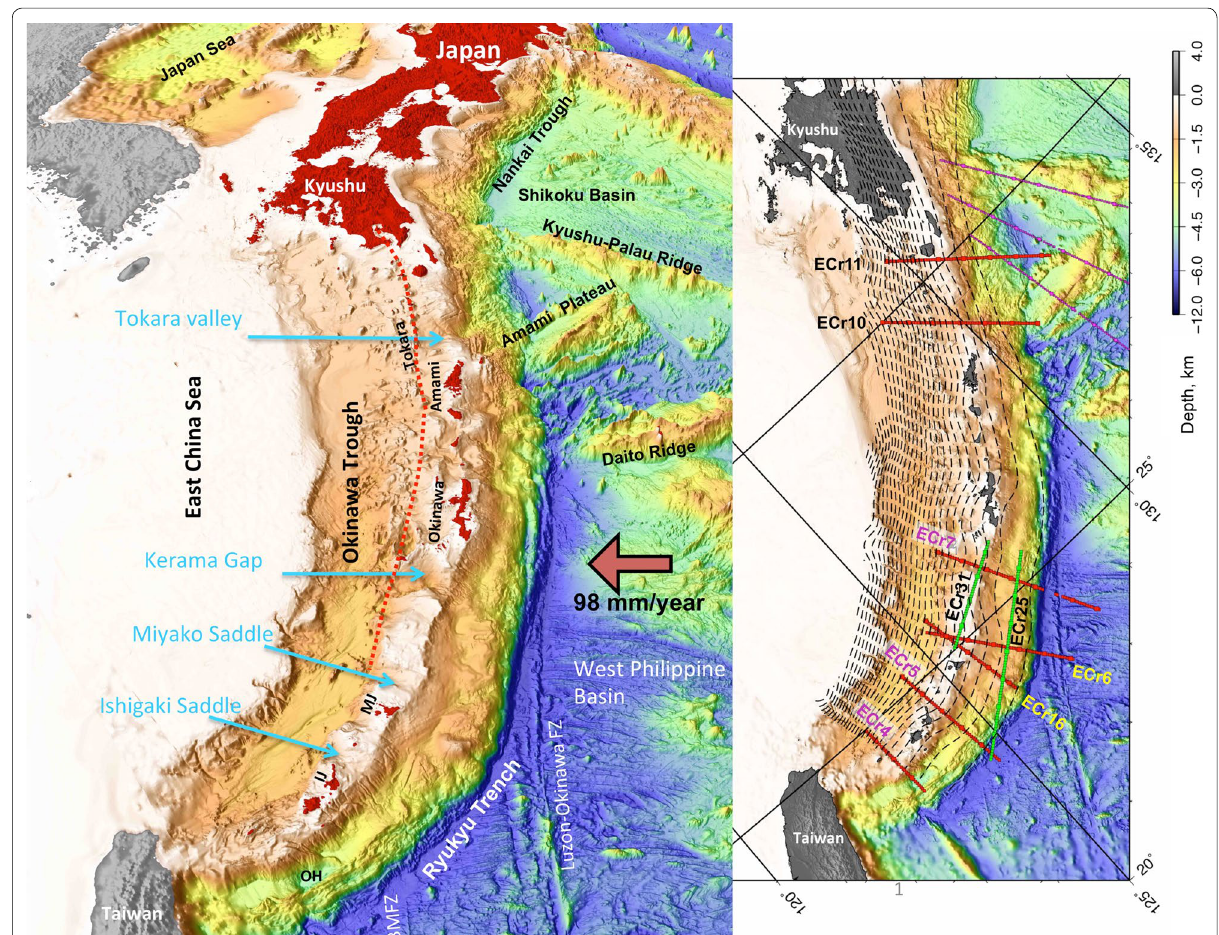
Fig. 1 Tectonic maps and locations of seismic lines. The characteristic seafloor topography of the Philippine Sea plate on the left and the position of the seismic lines ( red and green lines ) across and along the Ryukyu (Nansei-Shoto) arc on the right . The rough position of the volcanic front is shown in red dotted line . Three thin violet lines are previous seismic lines across the northernmost Ryukyu Trench (Nishizawa et al. 2009). A non-tuned airgun array with a capacity of 6000 (1500 4) cubic inch (98.3 L) was shot for the refraction survey and a 1050 (350 3) cubic inch (17.2 L) airgun cluster × × was used for the multichannel reflection survey. Broken lines indicate iso-depth contours of the plate interface with an interval of 10 km (Hayes et al. 2012). MJ Miyako-jima, IJ Ishigaki-jima, BMFZ Botan-Miyako fracture zone, OH Oki-Hateruma